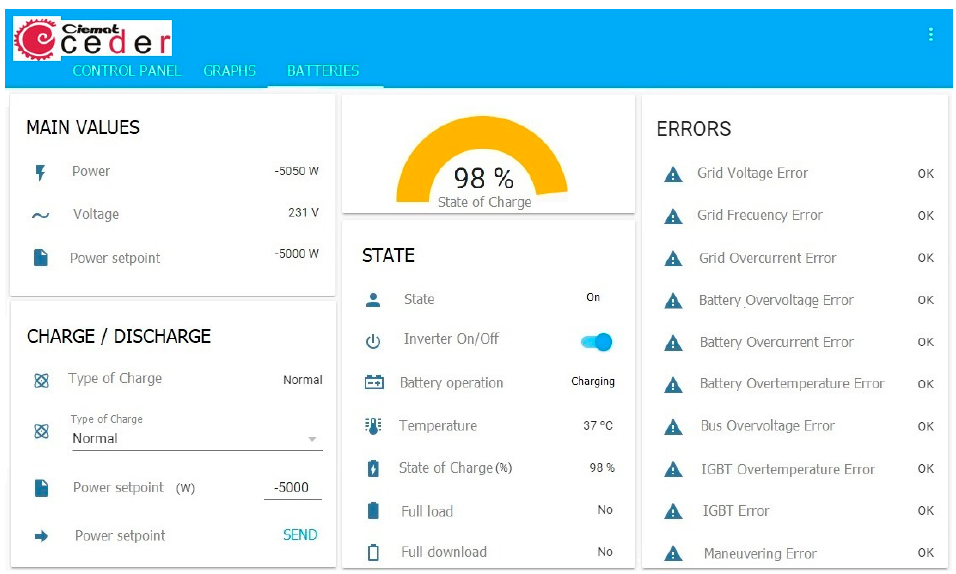
Figure 8. CEDER’s microgrid battery SCADA developed in Home Assistant. Source: prepared by authors. Home Assistant allows visualising in real time the value of the variables collected from each of the elements, as shown in Figure 9.